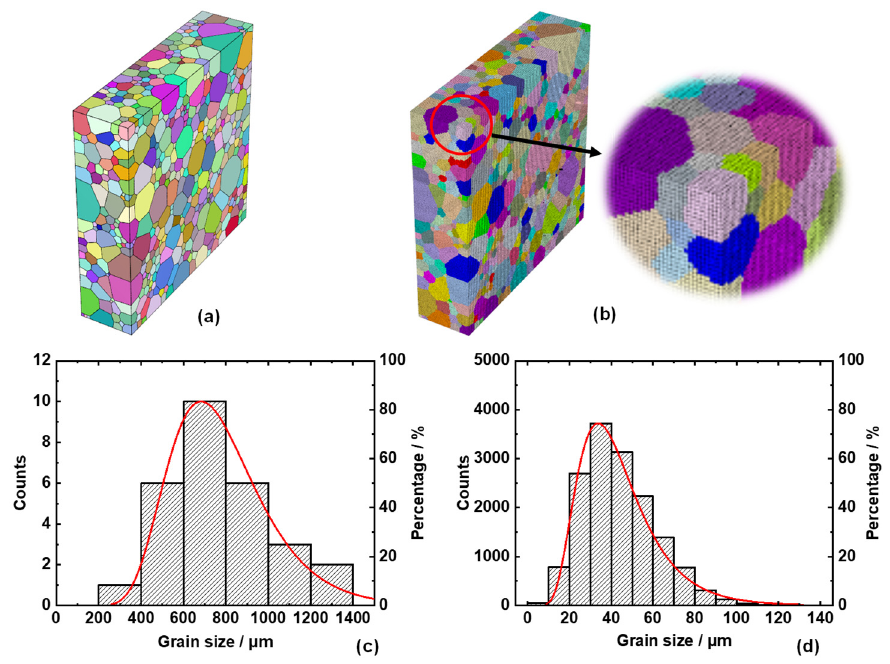
Figure 2. Polycrystalline ZnSe, its meshed morphology and the grain size distribution: ( a ) original sample; ( b ) meshed sample; ( c , d ) histograms of grain size distributions of a 3 × 3 × 1 mm 3 sample and a 1 × 1 × 1 mm 3 sample with an average grain size of approximately 800 and 40 µ m,